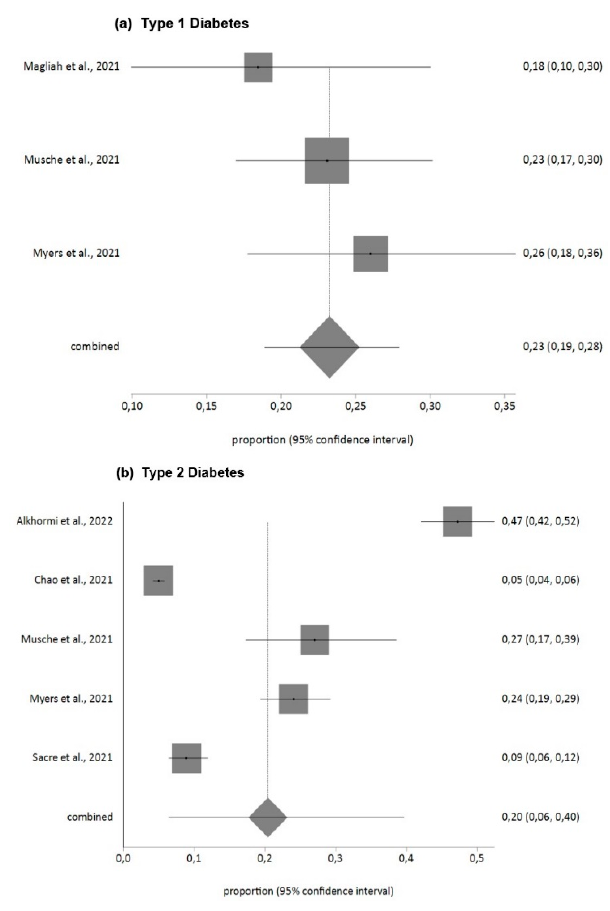
Figure 2. Prevalence of anxiety in DM patients during COVID-19 pandemic (GAD-7). ( a ) Type 1 Diabetes [48,51,52], ( b ) Type 2 Diabetes